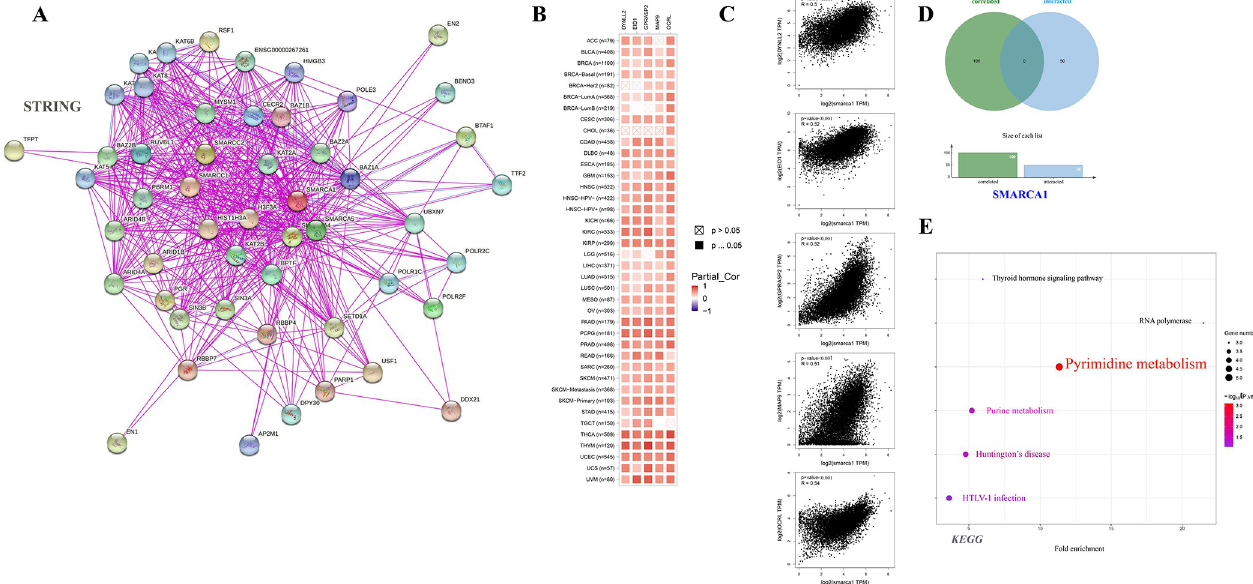
Fig 13. SMARCA1-related gene enrichment analysis. (A) SMARCA1-related functional proteins association networks with experimental determination via STRING database; (B) The heatmap of correlation analysis between SMARCA1 and the selected targeting genes of top 100 SMARCA1-related genes in all TCGA cancers; (C) The detailed correlation analysis between SMARCA1 and corresponding genes, including DYNLL2, EID1, GPRASP2, MAP9, and OCRL; (D) cross-analysis of the SMARCA1 correlated and interacted genes; (E) KEGG pathway analysis of SMARCA1-related genes.